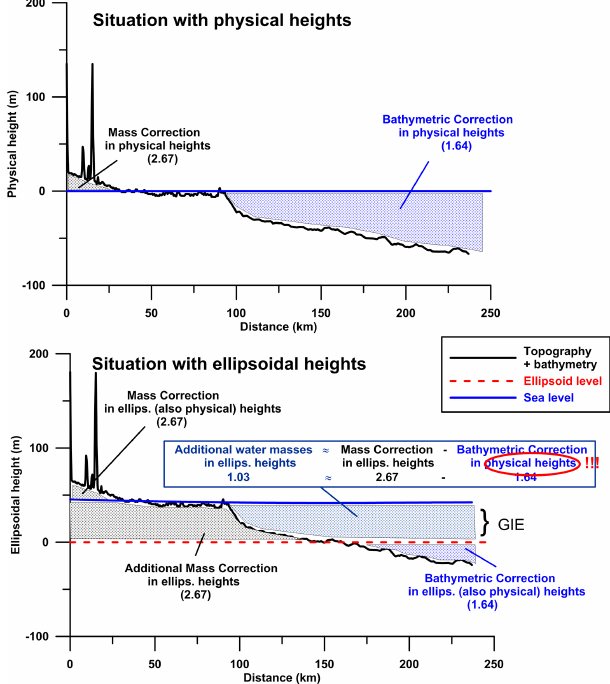
Figure 3. Schematic comparison of physical vs. ellipsoidal concept of CBA. Note that the effect of additional water masses is calculated in a two-step